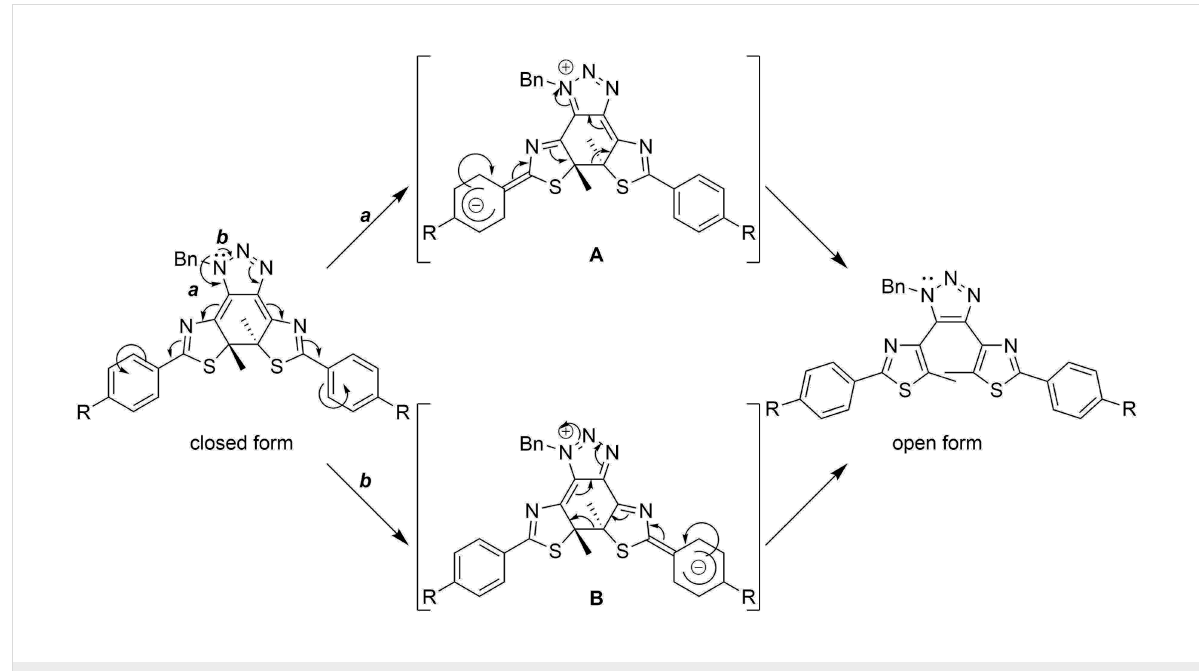
Scheme 6: Possible reaction mechanism of thermal ring opening of the closed